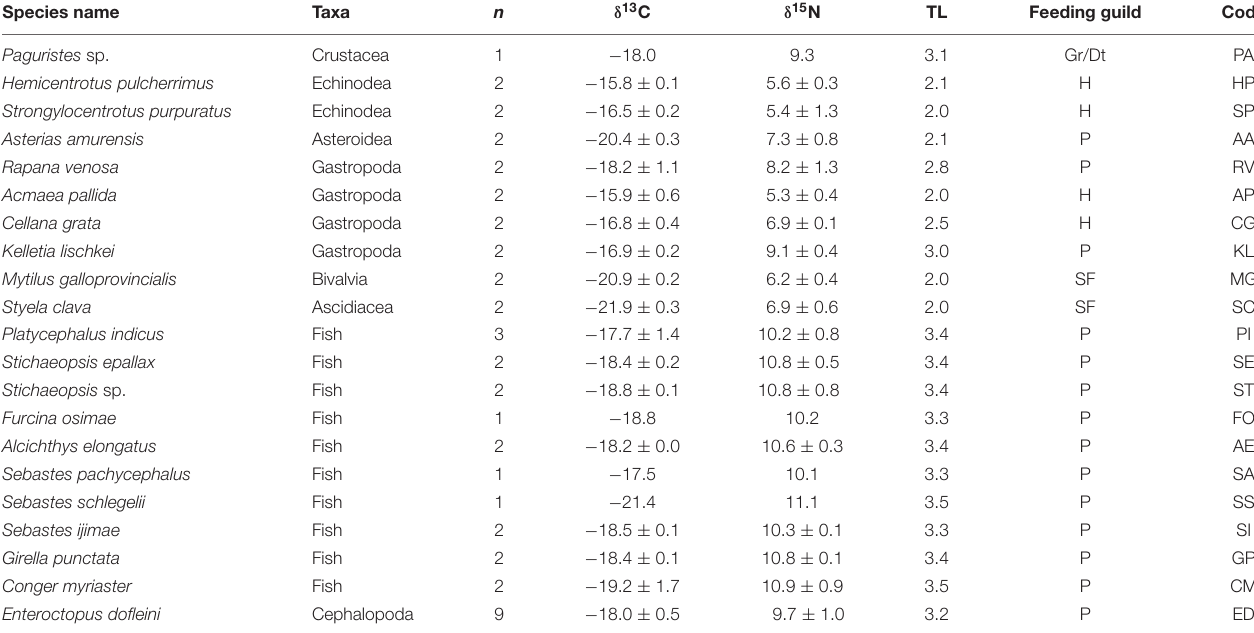
TABLE 3 | δ 13 C and δ 15 N values of Enteroctopus dofleini , macrobenthic invertebrates, and fish collected at the MH site.